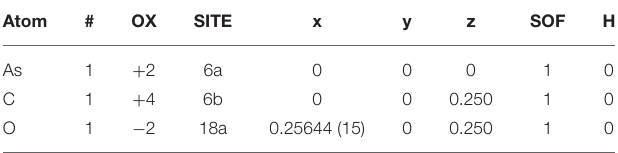
TABLE 1 | Space coordinates for the calcite model (Sitepu,